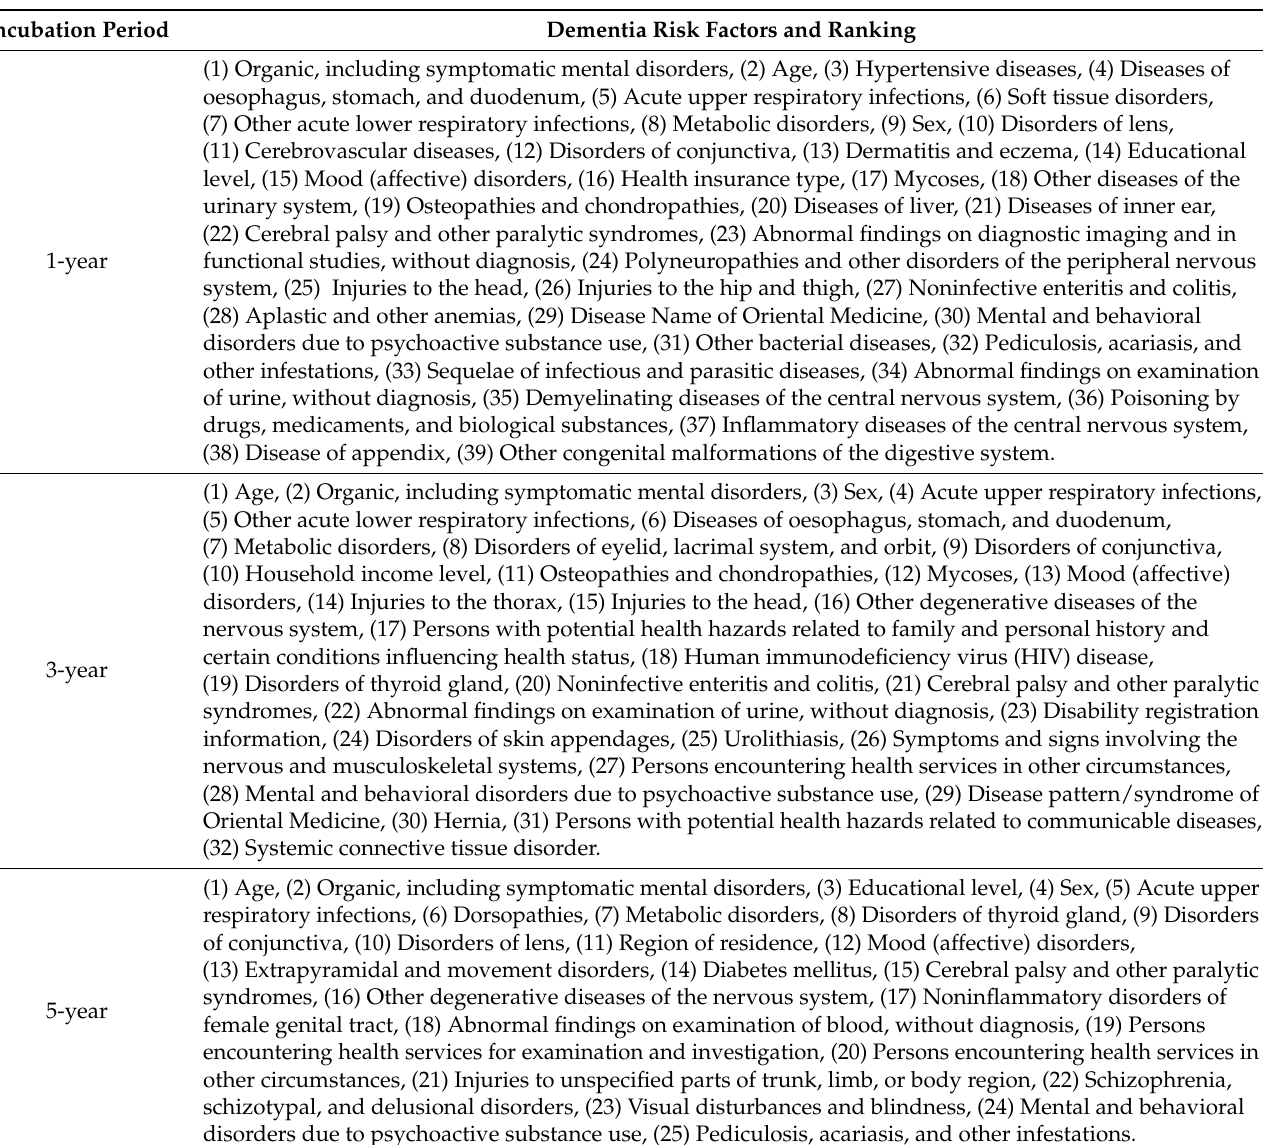
Table 7. Dementia risk factors according to the incubation period of